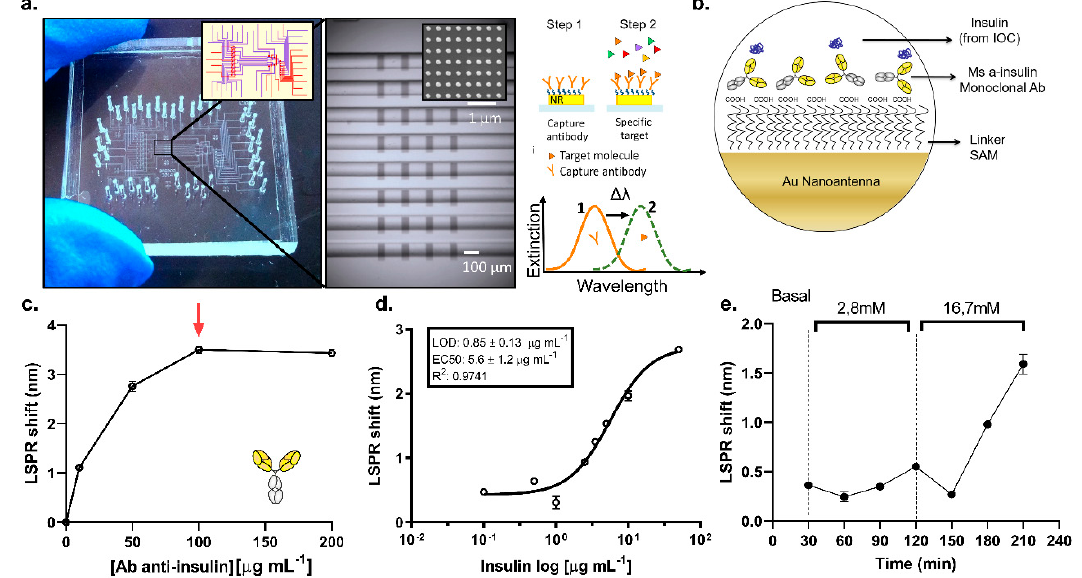
Figure 5. On-chip LSPR sensing platform description and detection. ( a ) Overview of LSPR sensing platform integrated by functionalized gold nanoantennas couple with a complex microfluidic network. ( b ) Functionalization strategy applied on gold nanoantenna sensors. ( c ) Optimization of capture monoclonal anti-insulin antibody. A saturation plateau is observed at 100 µ g mL − 1 antibody concentration (red arrow). ( d ) Calibration curve performed in KRBH basal glucose content (11.1 mM). Curve shows a limit of detection of (0.85 ± 0.13) µ g mL − 1 (n = 3). ( e ) Real-time insulin detection by the LSPR sensing platform every 30 min from the connected IOC device stimulated with KRBH buffer at low (2.8 mM) and high glucose (16.7 mM) concentrations, respectively.